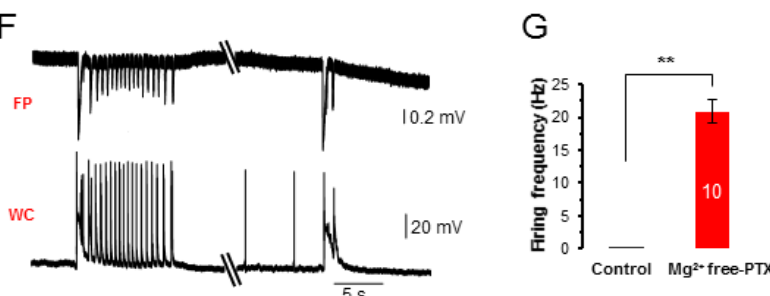
Figure 1. Epileptiform discharges induced by Mg 2+ free-PTX. ( A ) Differential interference contrast (DIC) image of a portion of the CA1 region in an acute hippocampal slice. Pyramidal neurons could be readily identified from the pyramidal neuron layer based on cell morphology. Whole-cell (WC) recording from a pyramidal neuron first in the voltage-clamp ( B ) , then current-clamp ( C ). ( B ) In voltage-clamp recording, the pyramidal neuron was held at -70 mV at resting and then stepped to command voltages ( V COM ) from − 160 mV to + 20 mV at 20 mV increment and 25 ms duration (lower inset in B ), and there was a 1 s interval between the consecutive V COM steps. The pyramidal neuron was characterized by large depolarization step-activated inward Na + and the following voltage-gated K + channel currents; a 0 mV V COM -induced initial inward I Na and following I Ka and I Kd are shown in the upper inset in ( B , C ) In the current-clamp recording, the current injection, 50 pA / 500 ms induced multiple action potentials that fired with adaptation. ( D ) Field potential (FP) recording from stratum radiatum region (lower electrode in A ), first in control, and then in Mg 2+ free-PTX as indicated. Two different forms of epileptiform discharge (ED) are shown. ( E ) The frequency of ED events in Mg 2+ free-PTX compared to control. ( F ) WC and FP dual recording; high frequency of neuronal firing is temporally phase-locked with ED. ( G ) High frequency of neuronal firing during ED events compared to non-ED events. **: p < 0.01.